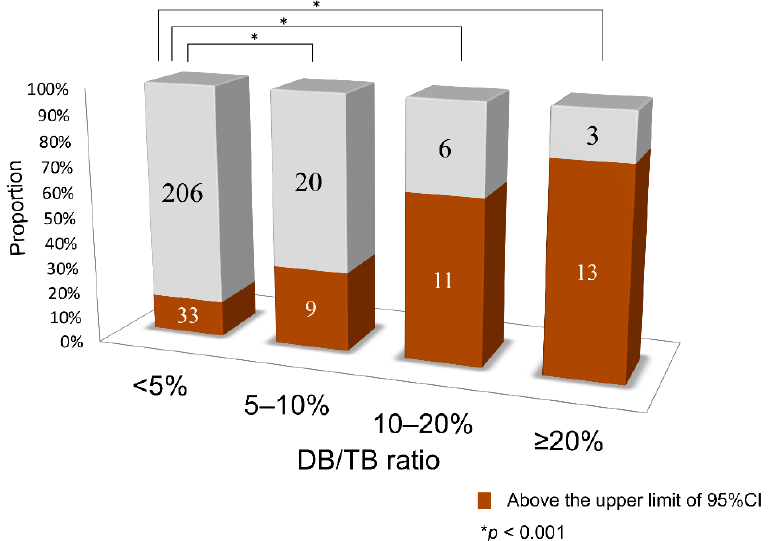
Figure 2. Comparison of the number of samples higher than the upper limit line of the 95% confidence interval of the DB/TB ratio <5% (outliers). CI, confidence interval; DB, direct bilirubin; TB, total serum bilirubin.